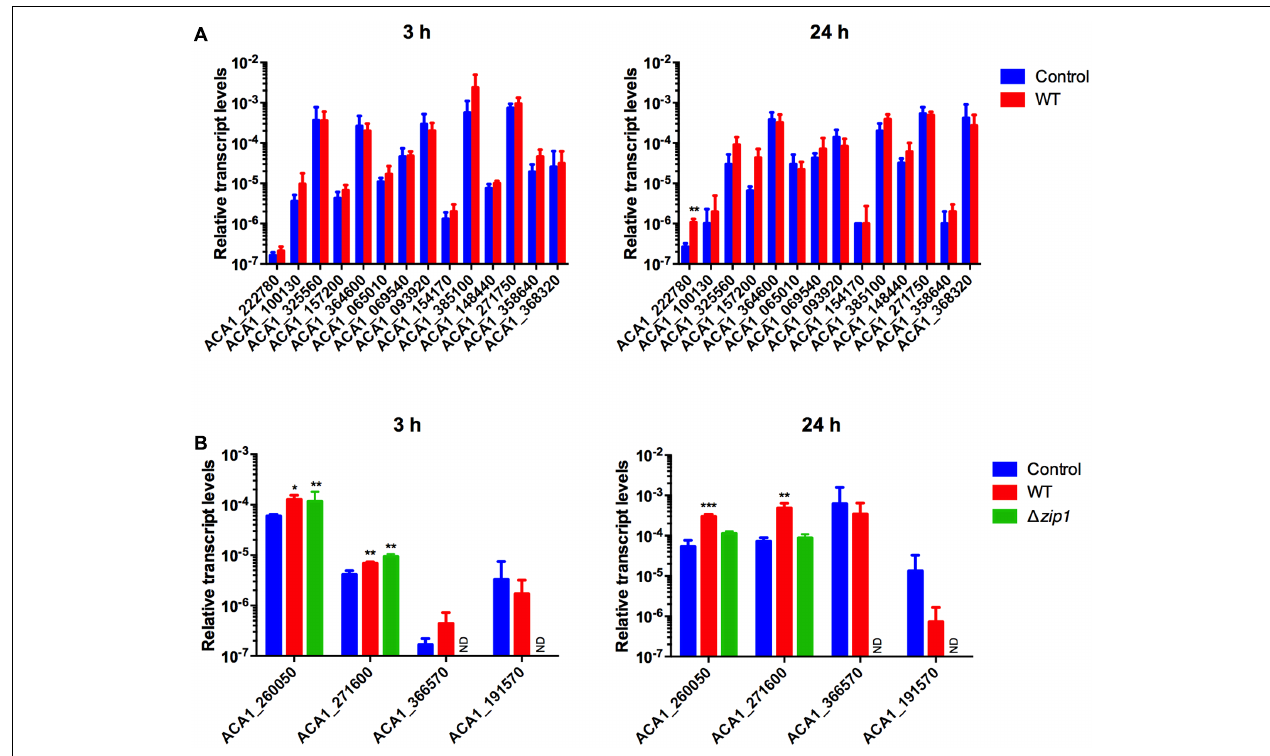
FIGURE 5 | Cryptococcus gattii presence alters zinc transporter expression in A. castellanii . Amoebae (1 × 10 5 cells) were incubated in PYG medium with C. gattii WT or zip1 (cid:49) (1 × 10 6 cells) in 12-well plates for 3 and 24 h, at 30 ◦ C. The cells were washed with PBS and RNA from amoebae was isolated and extraction was performed, followed by cDNA synthesis. The measured quantity of zinc transporter mRNA from ZIP coding genes (A) or ZnT coding genes (B) in each sample was normalized using the threshold cycle values obtained for the Actin gene. Data are shown as the mean ± standard deviation from three experimental replicates of three biological replicates. Statistical analysis by t -student comparing control and fungal presence groups for each transporter ( ∗ p < 0.05, ∗∗ p < 0.01, ∗∗∗ p < 0.001). ND,